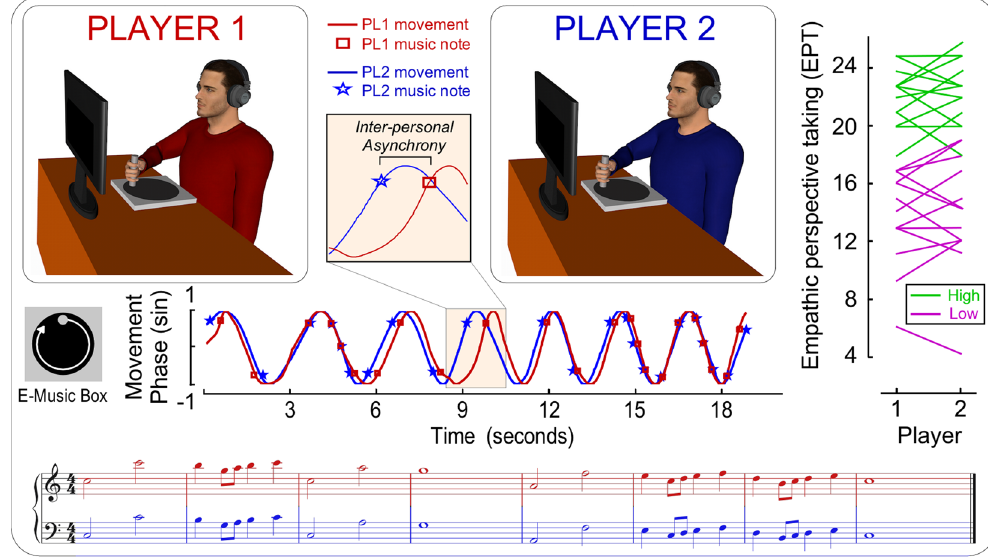
Figure 1. Experimental paradigm. Pairs of musically untrained participants use E-music boxes to perform a musical melody together. The E-music box transforms rotatory movements into a pre-programmed musical melody whose tempo varies according to the rotation velocity. When the E-music box is rotated at constant velocity, the melody is played with correct rhythm and constant tempo (for details see) 59 . Participants are instructed to synchronize their musical outputs as accurately as possible. Their movements are therefore highly controlled and entail continuous rotations of their right arms. The latency of movements and outputted musical tones are used to study interpersonal coordination accuracy, as well as leader-follower relations. Before taking part in the study, each participant is paired with another individual having a similar empathic perspective taking (EPT) score (i.e. their score difference is not larger than 3). Eventually, groups of relatively higher and lower EPT pairs are compared one another following a median